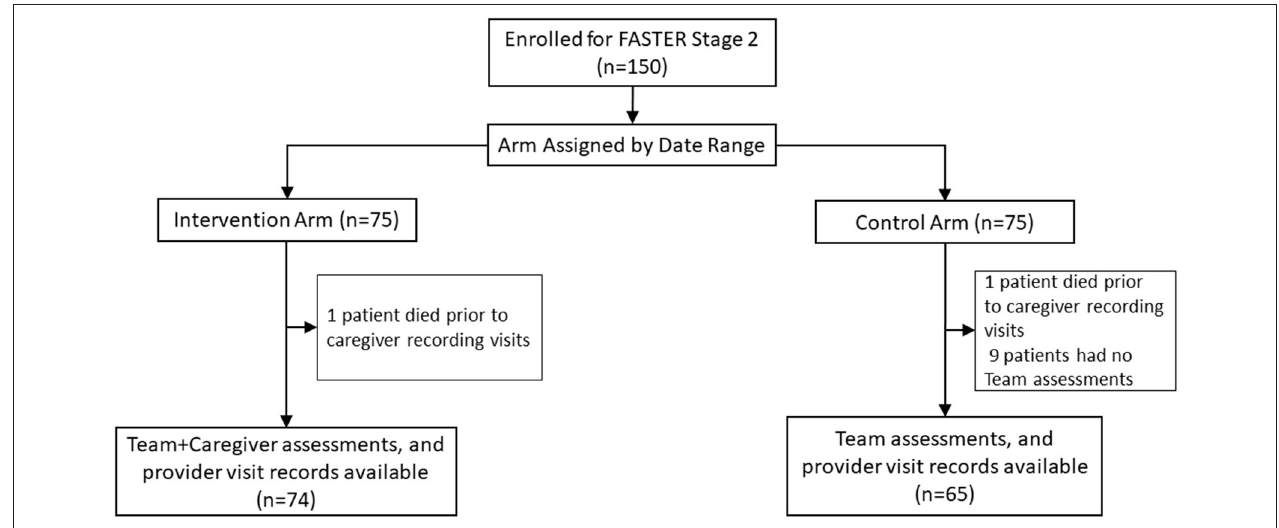
FIGURE 1 | Consort flow